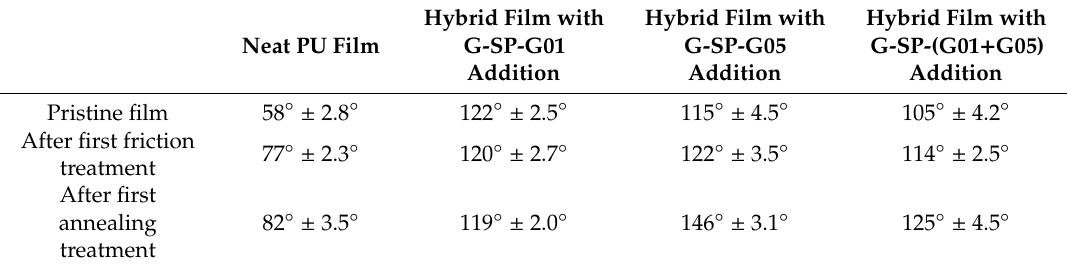
Table 1. Contact angle for the UV-cured coatings during the first friction-annealing cycle.